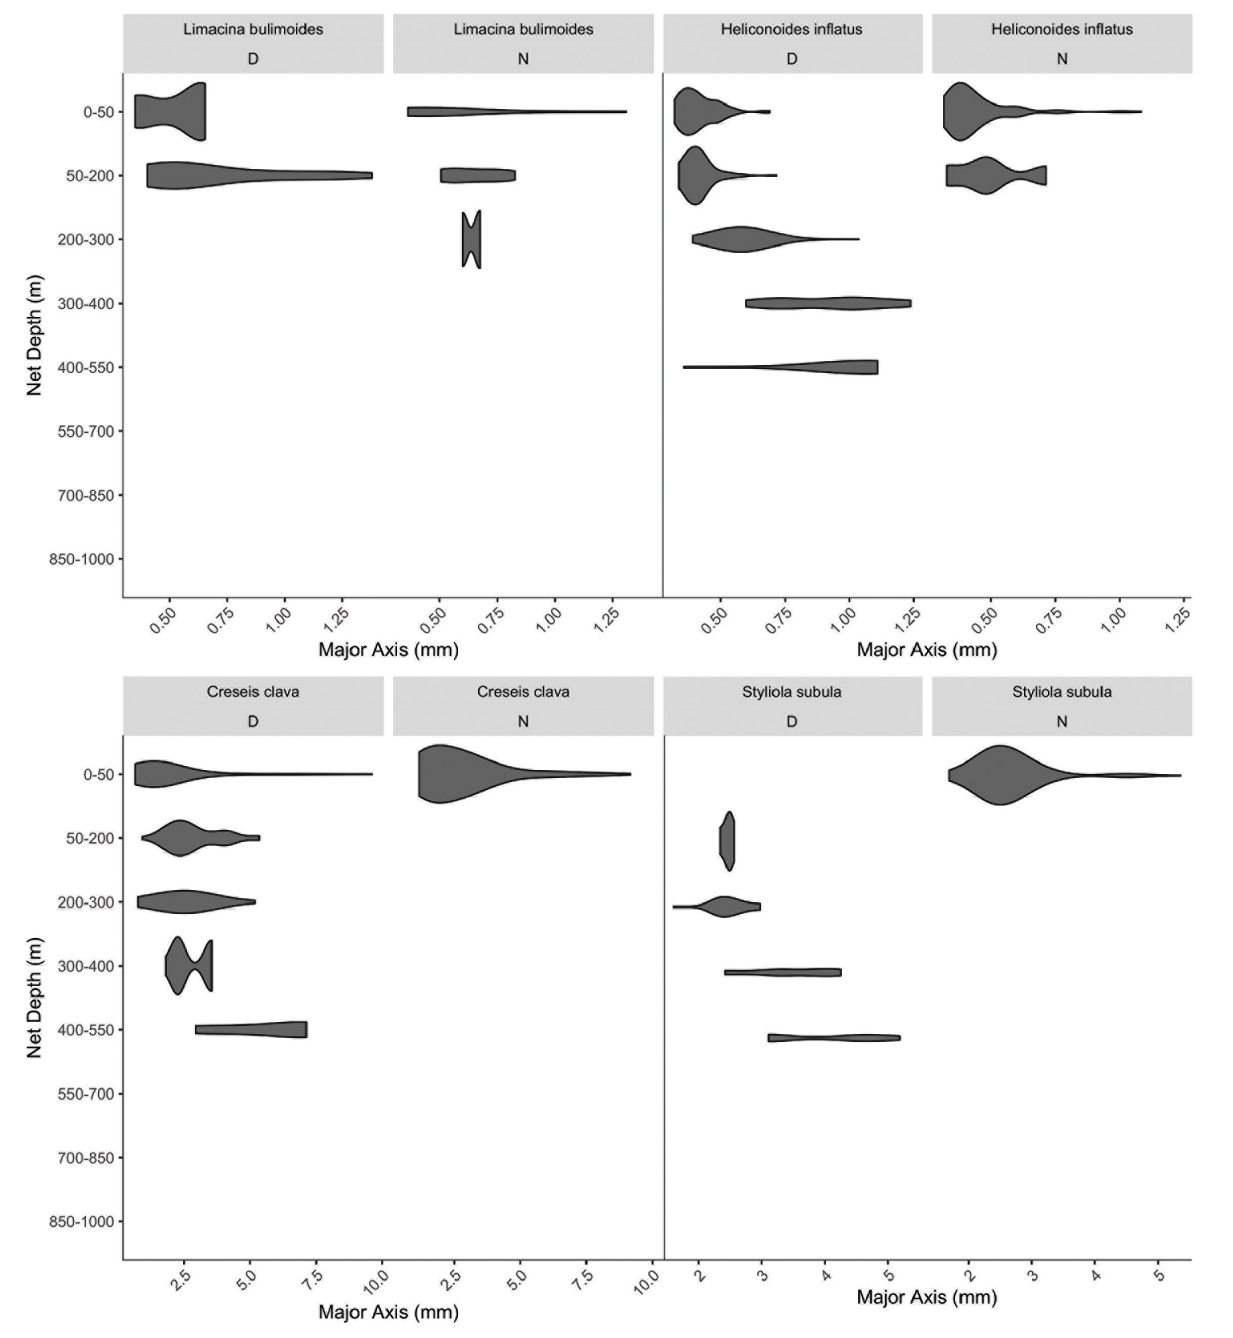
FIGURE 10 | Day and Night vertical distribution of species from MOCNESS net image data. The length of the organisms ( x -axis) is plotted versus the median depth of the net of collection ( y -axis) to demonstrate size-based differences in habitat selection. The width of the bar corresponds to relative abundance of individuals in that size